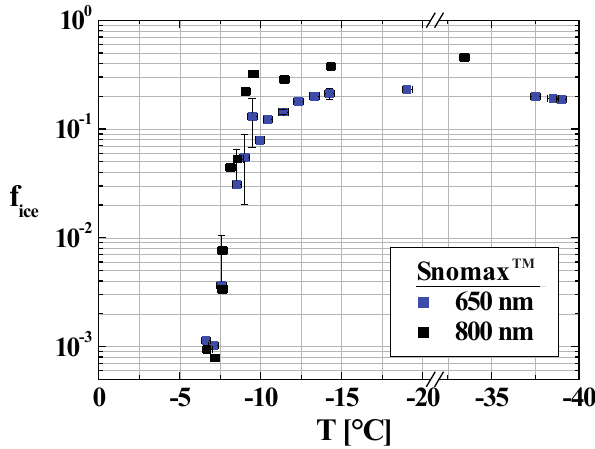
Fig. 3. Ice fraction f ice as function of temperature T for 650nm and 800nm particles generated from a Snomax TM